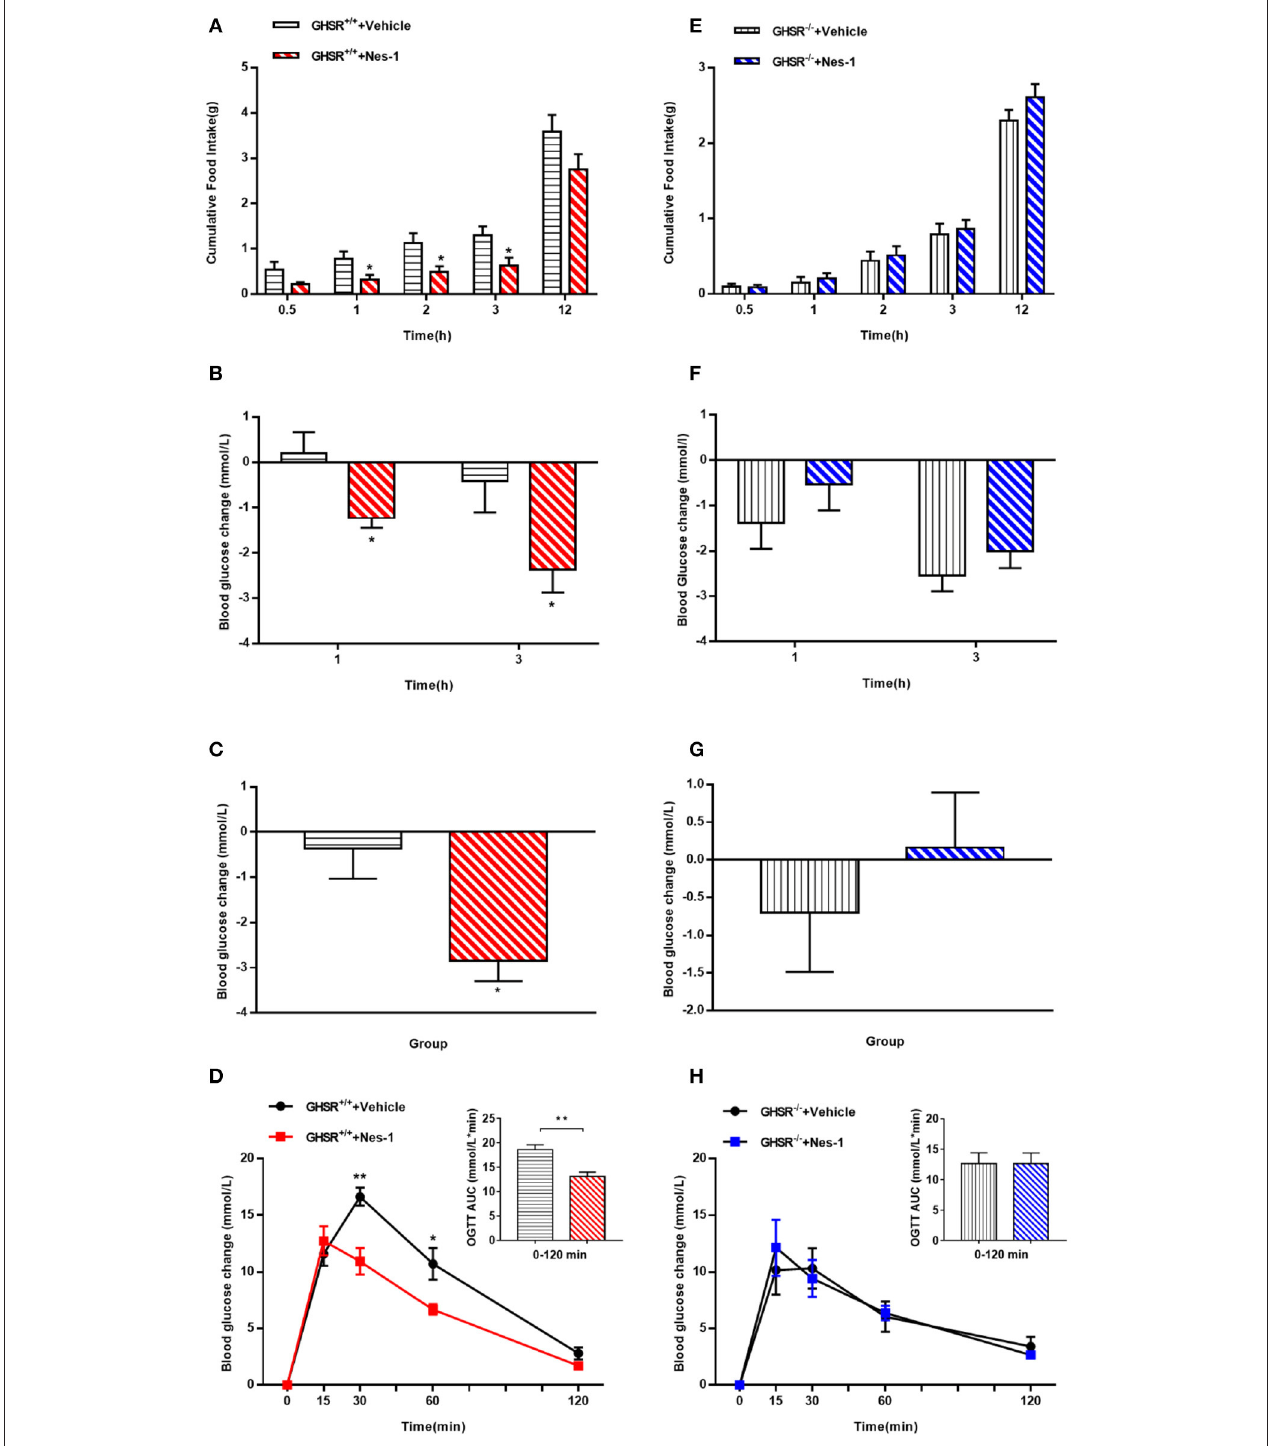
FIGURE 5 | Ghrelin receptor knockout blocked nesfatin-1’s effects on food intake and glucose metabolism in HFD-fed mice. GHSR + / + and GHSR − / − mice fed HFD underwent chronic tail vein administration of vehicle or nesfatin-1 (Nes-1) for 11 days, respectively. (A,E) Food intake and (B,F) blood glucose changes after one acute injection in two types of mice fasting for 6h. (C,G) Blood glucose changes after 11-day chronic injection compared with drug treatment prior. (D,H) OGTT after 8 days of injection in mice fasting for 16h. Data are expressed as mean ± SEM. GHSR + / + + Vehicle, GHSR + / + + Nes-1: n = 6/group; GHSR − / − + Vehicle, GHSR − / − + Nes-1: n = 5/group. * P < 0.05; ** P < 0.01 for the effect of nesfatin-1 vs. vehicle in GHSR + / + mice. Student’s t -test was applied to analyze the statistical difference.